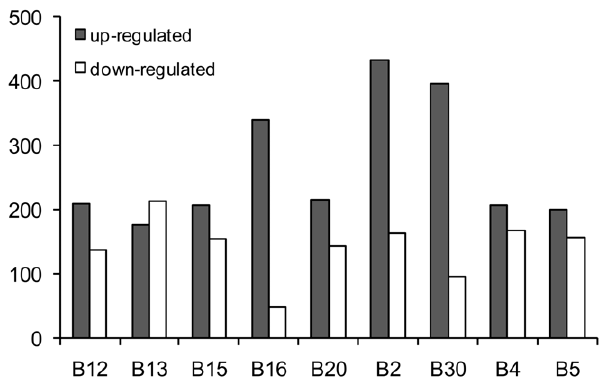
Figure 2. The counts of upregulated and downregulated miRNAs. Many miRNAs were determined to be significantly upregu- lated or downregulated in bladder urothelial carcinoma compared to matched histologically normal urothelium in nine patients by deep sequencing. The counts of upregulated and downregulated miRNAs varied across the nine patients. In eight out of nine bladder urothelial carcinoma patients upregulated miRNAs were more common than downregulated ones. In only one patient (Patient No. B13), upregulated miRNAs were less common than downregulated ones.